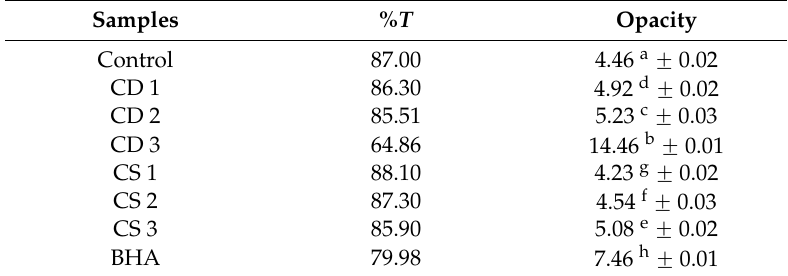
Table 3. Light transmission (% T ) and opacity of gelatine films with CD and CS extracts at different concentrations of the different gelatine films.